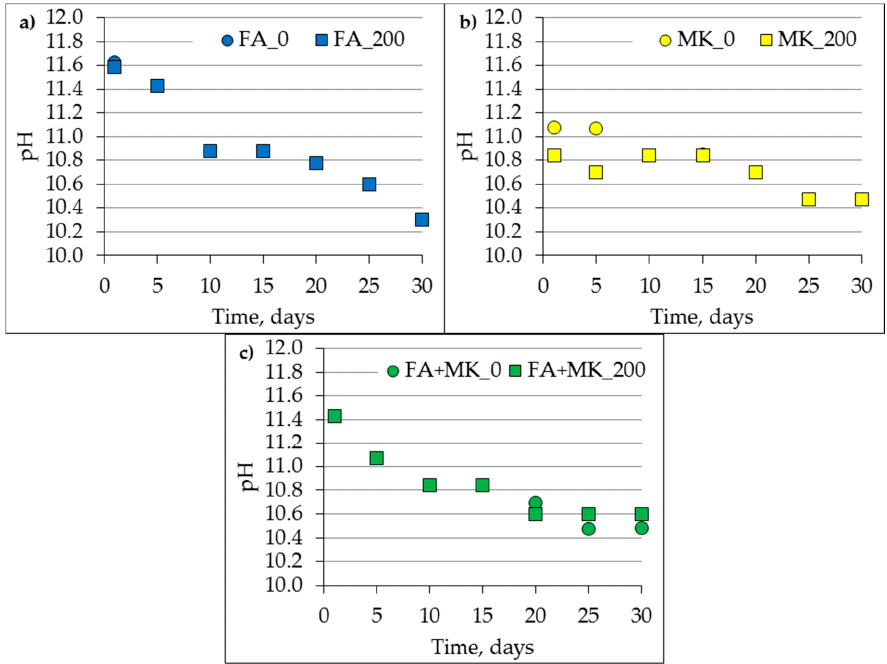
Figure 10. The pH changes in time ( a ) for samples FA_0 and FA_200; ( b ) for samples MK_0 and MK_200; ( c ) for samples FA + MK_0 and FA + MK_200. Minerals 2020 , 10 , x FOR PEER REVIEW